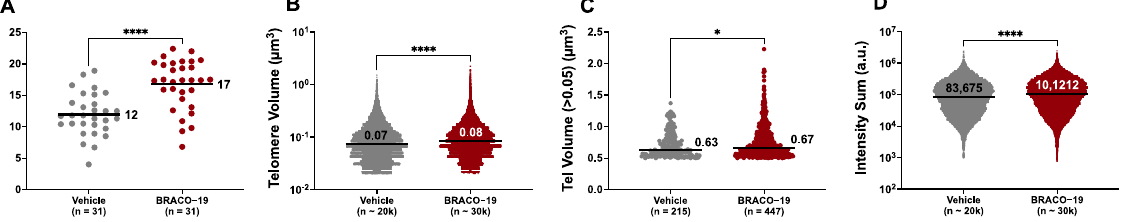
Figure 6. Evidence of telomere instability upon treatment with BRACO-19. a.u. signifies arbitrary units. In comparison with Atrx KO mice administered with vehicle (dH 2 O) ( n = 4), Atrx KO mice administered with BRACO-19 ( n = 4) for 40 days exhibit significantly higher number of telomeres per pancreatic islet cell nuclei ( A ), significantly increased telomere volume ( B,C ), and significantly increased intensity sum of FITC-stained telomeres ( D ). Data of graph A passed the normality tests, an unpaired t-test was then performed, and the mean values are presented. Data of graphs B–D did not pass the normality tests, so Mann–Whitney tests were then performed, and the median values are presented. A Log 10 scale and an Antilog tick format were used for the representation of the intensity sum ( D ). * p < 0.05, **** p < 0.0001.